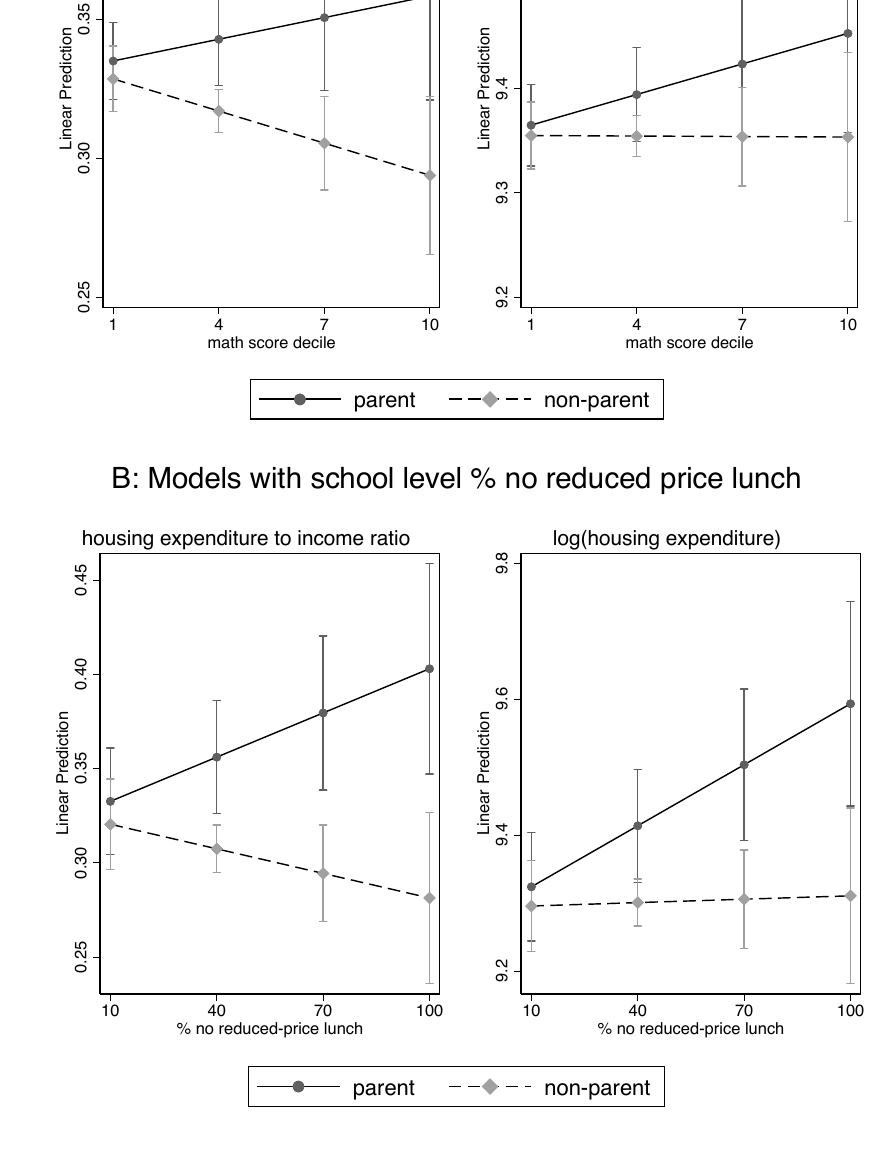
sociological science |